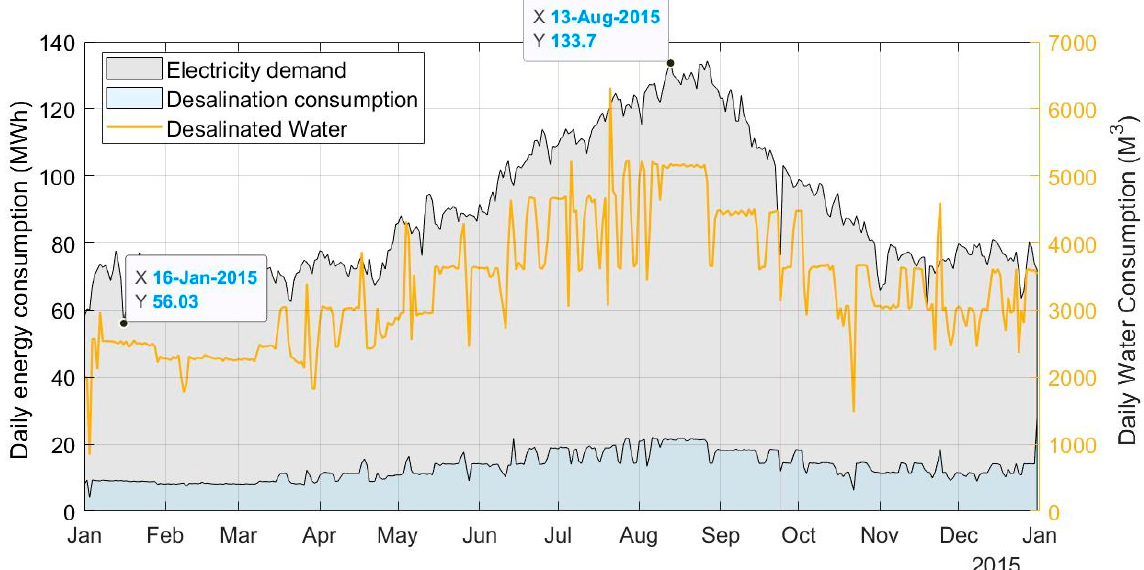
Figure 1. Daily electricity and water demand profile for the year 2015. Presented data were gathered through communications with the local water company (Aguas e Residuos da Madeira, S. A.) and the local electricity company (Empresa de Elelectricidade da Madeira).